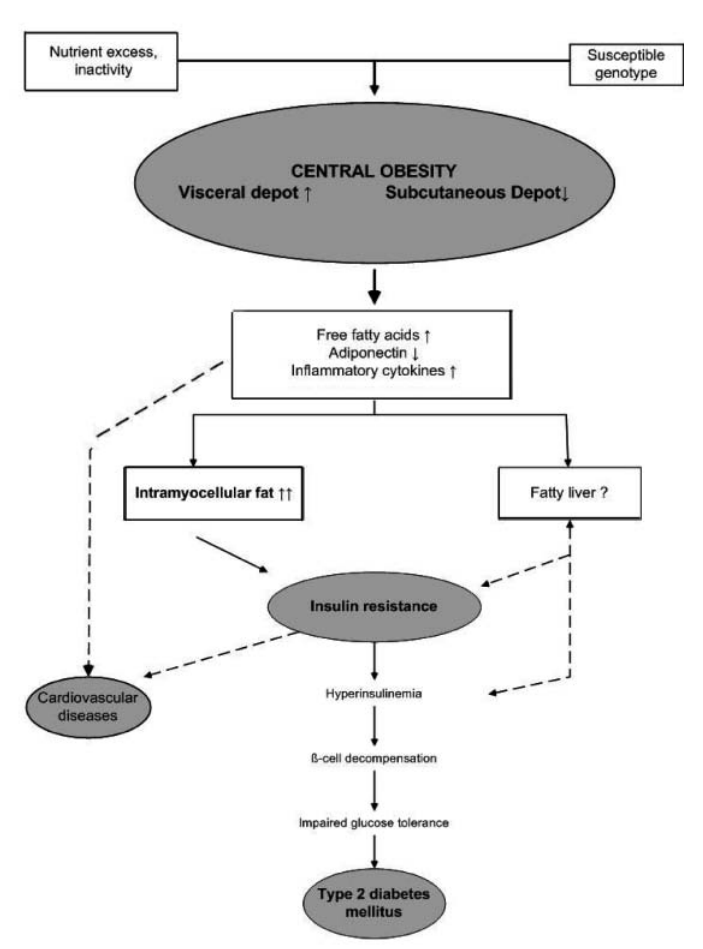
Figure 1. Mechanism of the influence of obesity on cardiovascular diseases and type 2